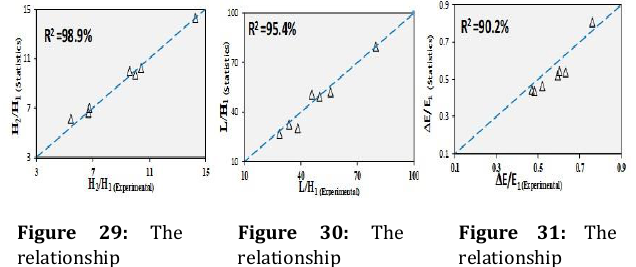
Figure 30: The relationship between the validating values of the comparative length of the free H. jump Eq. (3) and the experimental measurements.